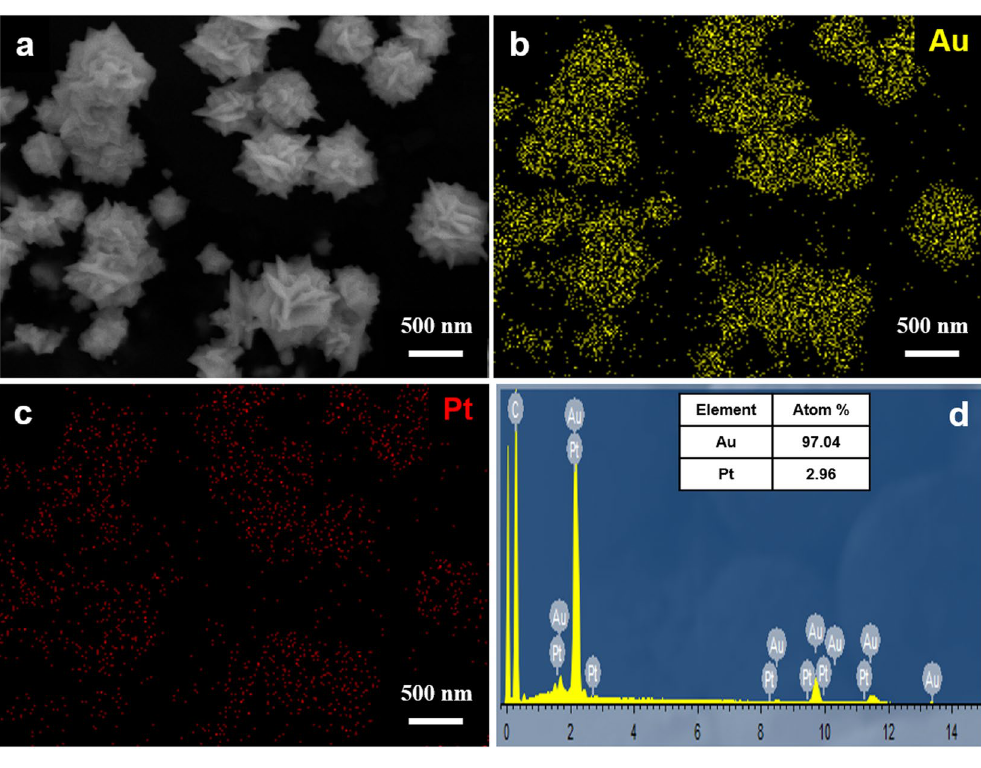
Figure 3. ( a ) FESEM image, EDS elemental mapping images of ( b ) Au and ( c ) Pt taken from AuPt NFs. ( d ) The corresponding EDS spectrum. Inset: the atomic ratio of Au and Pt.